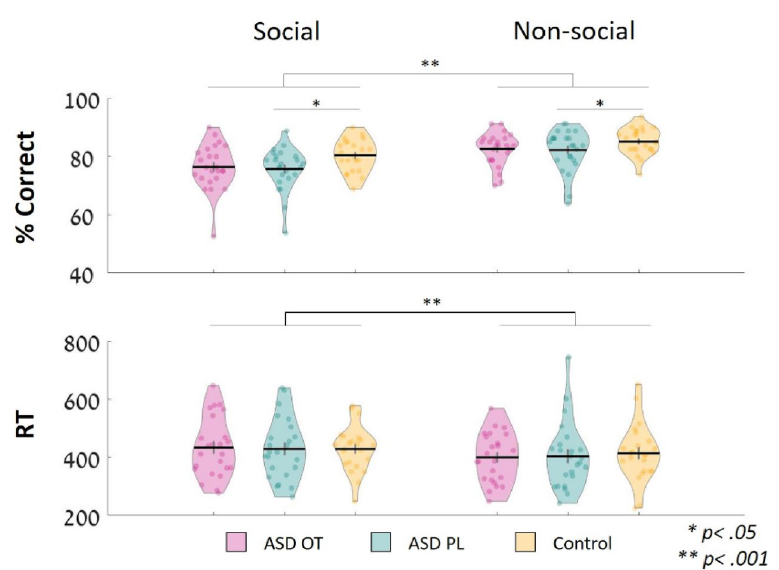
Figure 6. Behavioral results for accuracy rates and reaction times. After OT administration, the accuracy rates of the autistic individuals more closely resembled those of the TD study group. Analyses also revealed that all individuals presented higher ACC and lower RTs in the non-social trials. Accuracy (top panel) and RT (bottom panel) in response to social (left side) and non-social (right side) stimuli in the ASD-OT, ASD-PL, and control groups. Black lines represent the mean values of the groups. Vertical lines represent 1 SEM. Dots represent the individual data in the